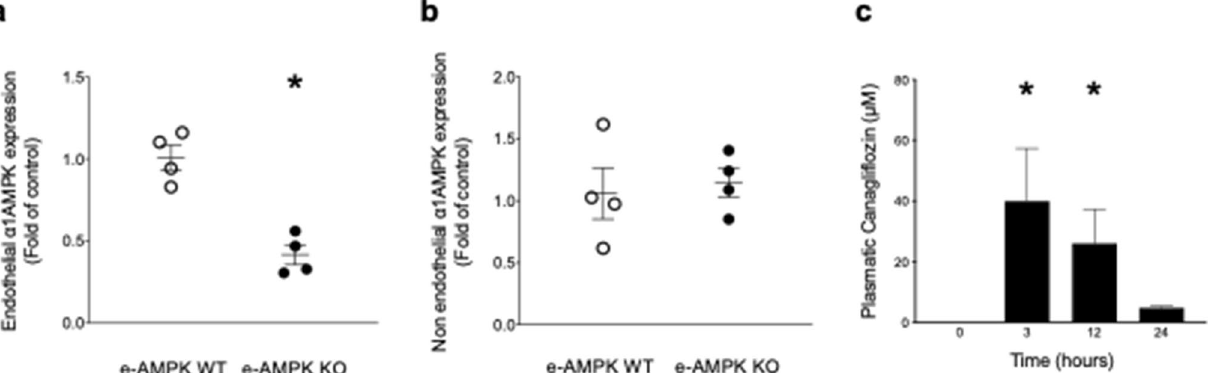
Figure 1. Generation and validation of the experimental model. e-AMPK WT/KO mice were intraperitoneally administered Tamoxifen (500 µg/mice) for 5 consecutive days in order to induce ⍺ 1AMPK invalidation specifically in the endothelium. 3 weeks after the last Tamoxifen injection, mice were sacrificed and endothelial cells were immunoprecipitated from lung tissue with dynabeads. ⍺ 1AMPK gene expression was detected by TaqMan qPCR on both isolated endothelial cells and supernatants. ( a ) Validation of endothelial ⍺ 1AMPK deletion’s extent in e-AMPK KO. ⍺ 1AMPK expression detected by TaqMan qPCR in immunoprecipitated endothelial cells. ( b ) Validation of endothelial ⍺ 1AMPK deletion’s specificity. ⍺ 1AMPK expression detected by TaqMan qPCR on lysates of lung tissue depleted of endothelial cells. ( c ) Time course of canagliflozin plasma levels in mice treated by oral gavage, 100 mg/kg, during indicated time. The data are mean ± SEM, n = 3 to 5/ group. The data were analyzed using one-way ANOVA